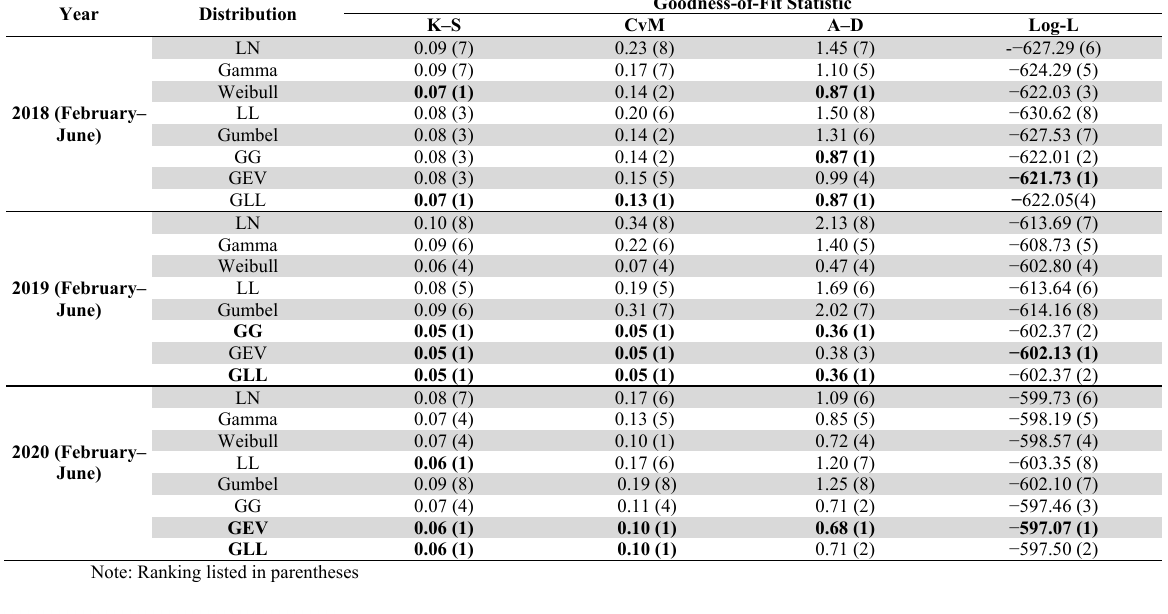
Goodness-of-fit statistics of the compared distributions in fitting data of PM 2.5 concentrations in the periods of February–